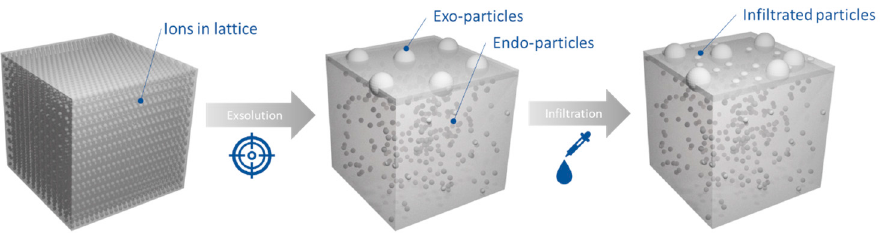
Figure 1. Functionalizing the surface of endo/exo-particle systems to lower methane activation temperature.